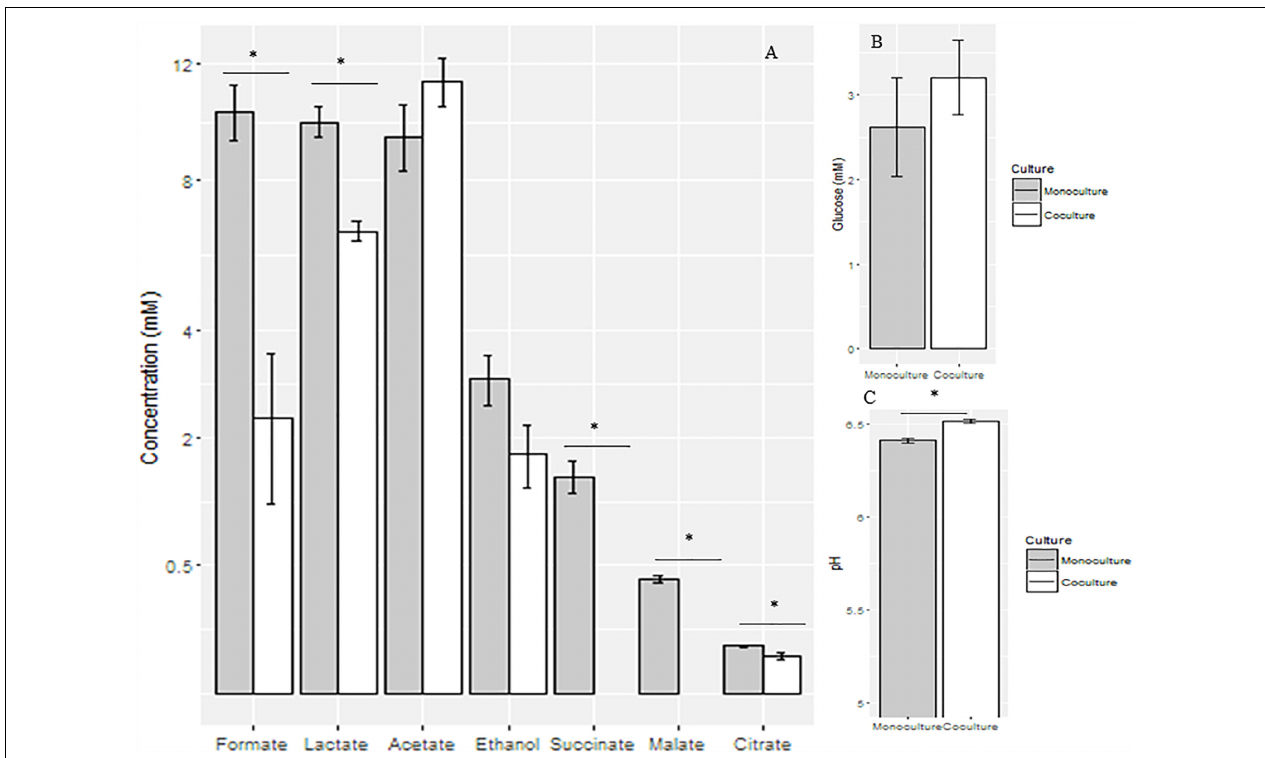
FIGURE 2 | Concentrations of fermentation end products (A) and glucose (B) and pH values (C) in the supernatant of anaerobic fungal monoculture and co-culture at the mid-growth stage. ∗ Means significant difference between two